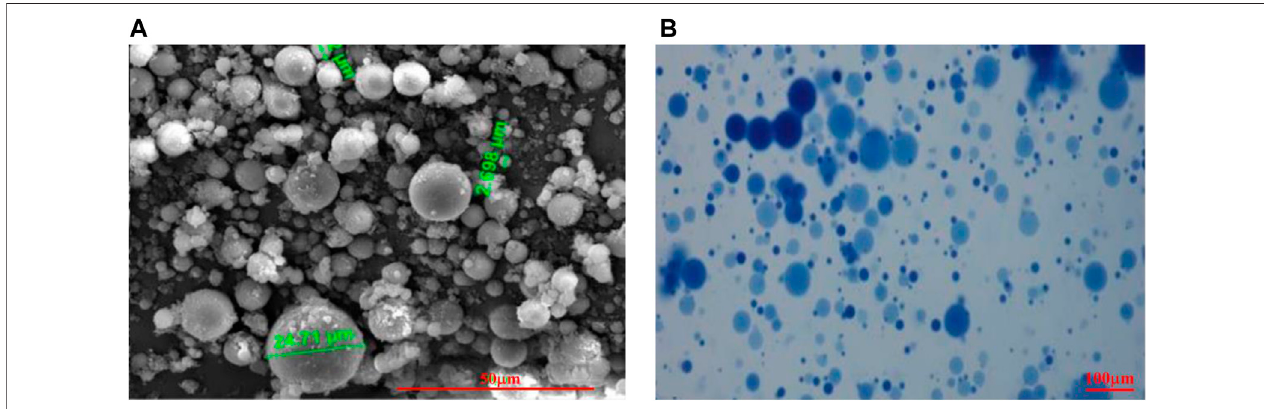
FIGURE 3 | Shape of PMs at different hydration times: (A) is the shape ofPMs taken with SEM initial state; (B) isthe shape after hydration 1 day taken with lighting microscope.